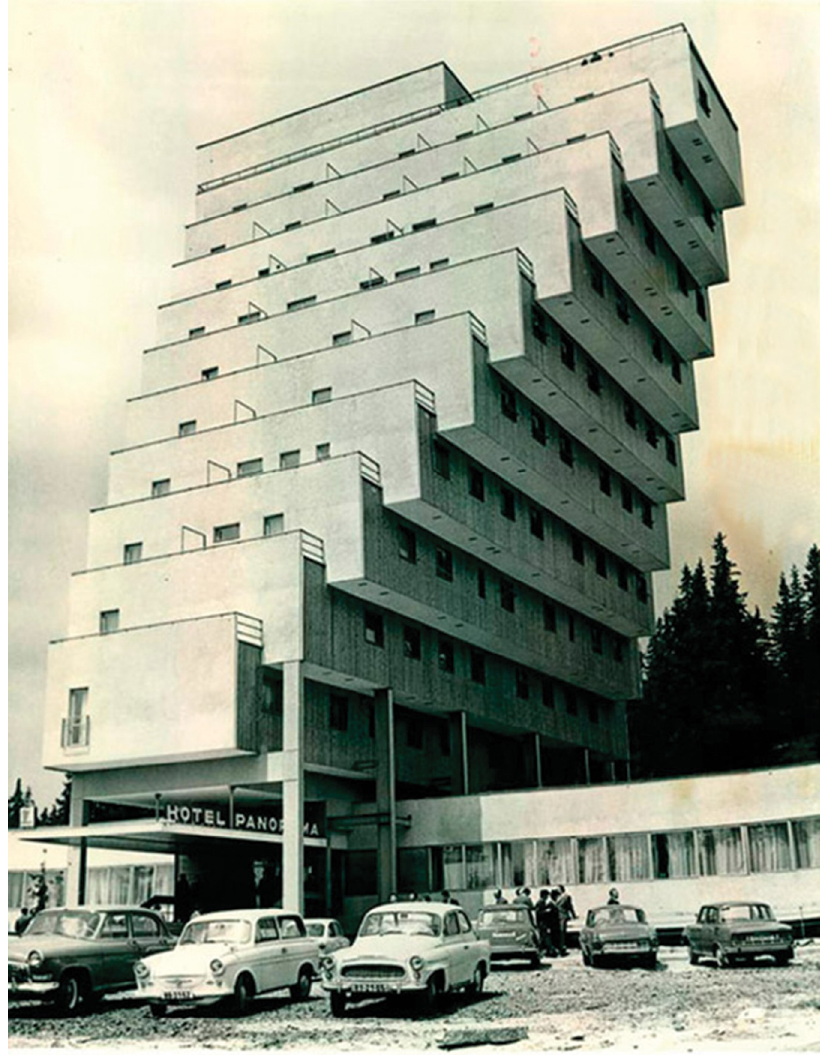
Figure 2. Slovakia, Strbske Pleso, Panorama Hotel Ski Resort. (Rossiyskaya Gazeta. “Relics of Constructivist Architecture in Post-Soviet Countries” Russia beyond the Headlines, August 21, 2013